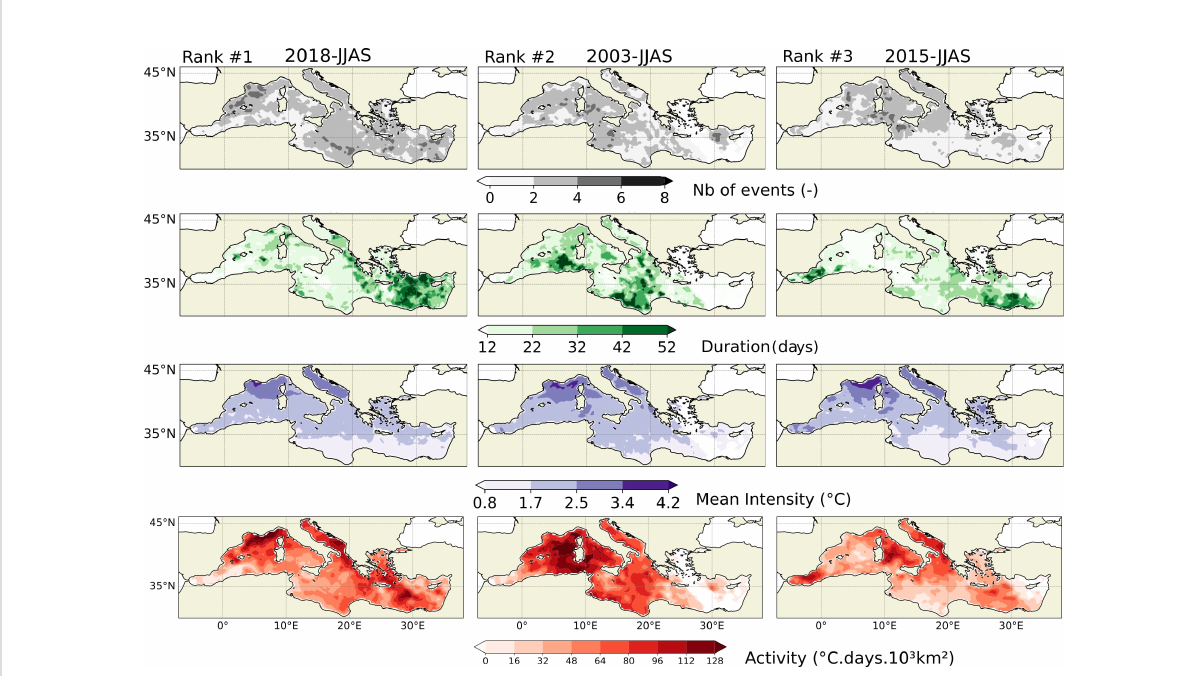
FIGURE 3 Number of events ( fi rst row), average duration (second row; in days), average intensity (third row; °C) and activity (fourth row; °C x days x 10³ km²) for the three summers (JJAS) having the highest MHW total activity in the Mediterranean (from left to